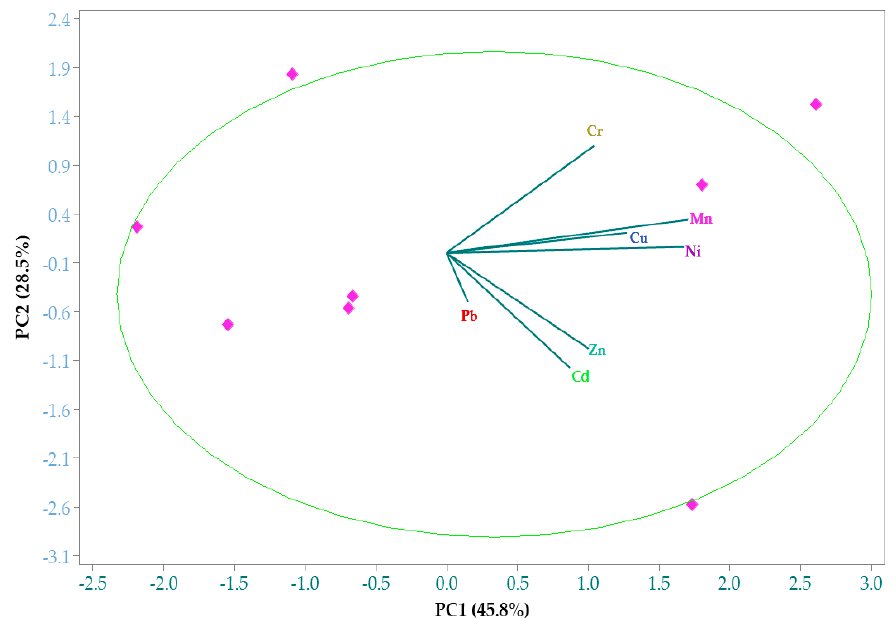
Figure 3. Loadings of principal components for the seven potentially (eco)toxic elements in dust samples from selected highways, pedestrian bridges and urban roads in Eastern Uganda. PC1 = First principal component, and PC2 = Second principal component.